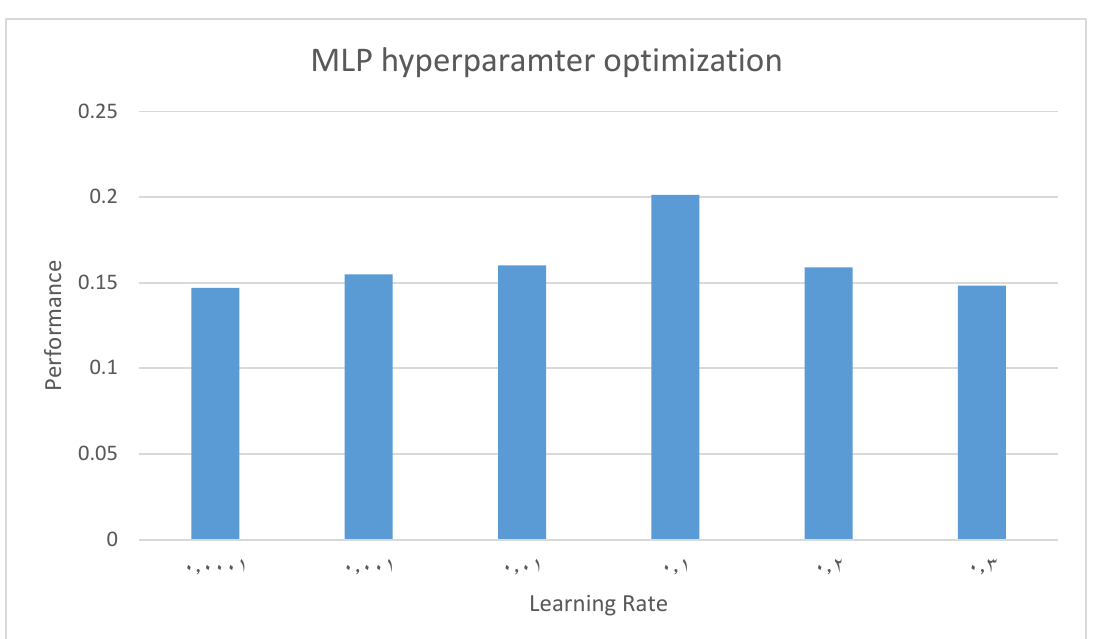
Figure A-2 Optimized Learning Rate of MLP